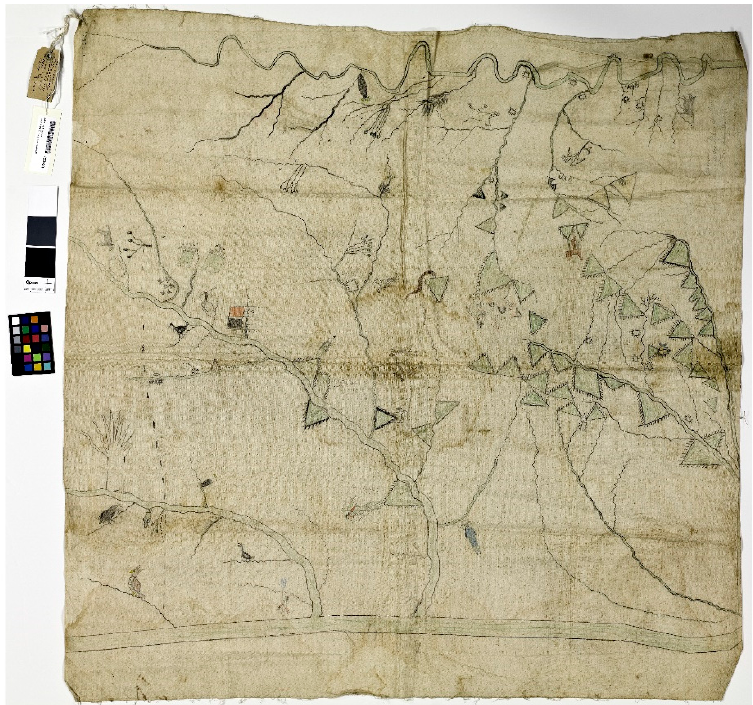
Figure 2. The complete Kiowa map. Source: National Museum of Natural History.